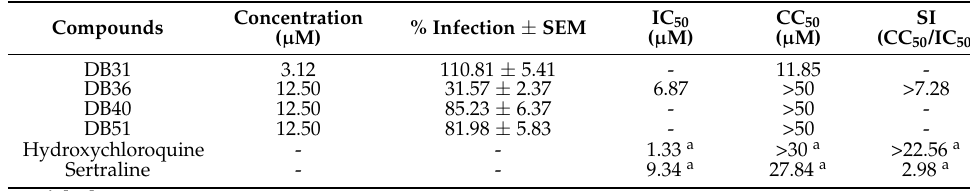
Table 2. Antiviral infection activity of hit